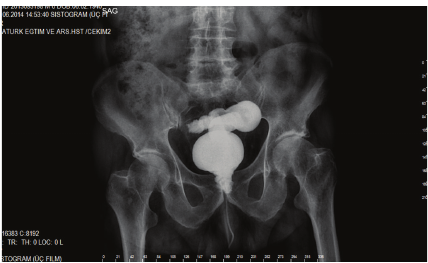
Figure 9: Leakage of radiopaque material filling the rectum by passing through rectourethral fistula was seen preoperatively in cystography.